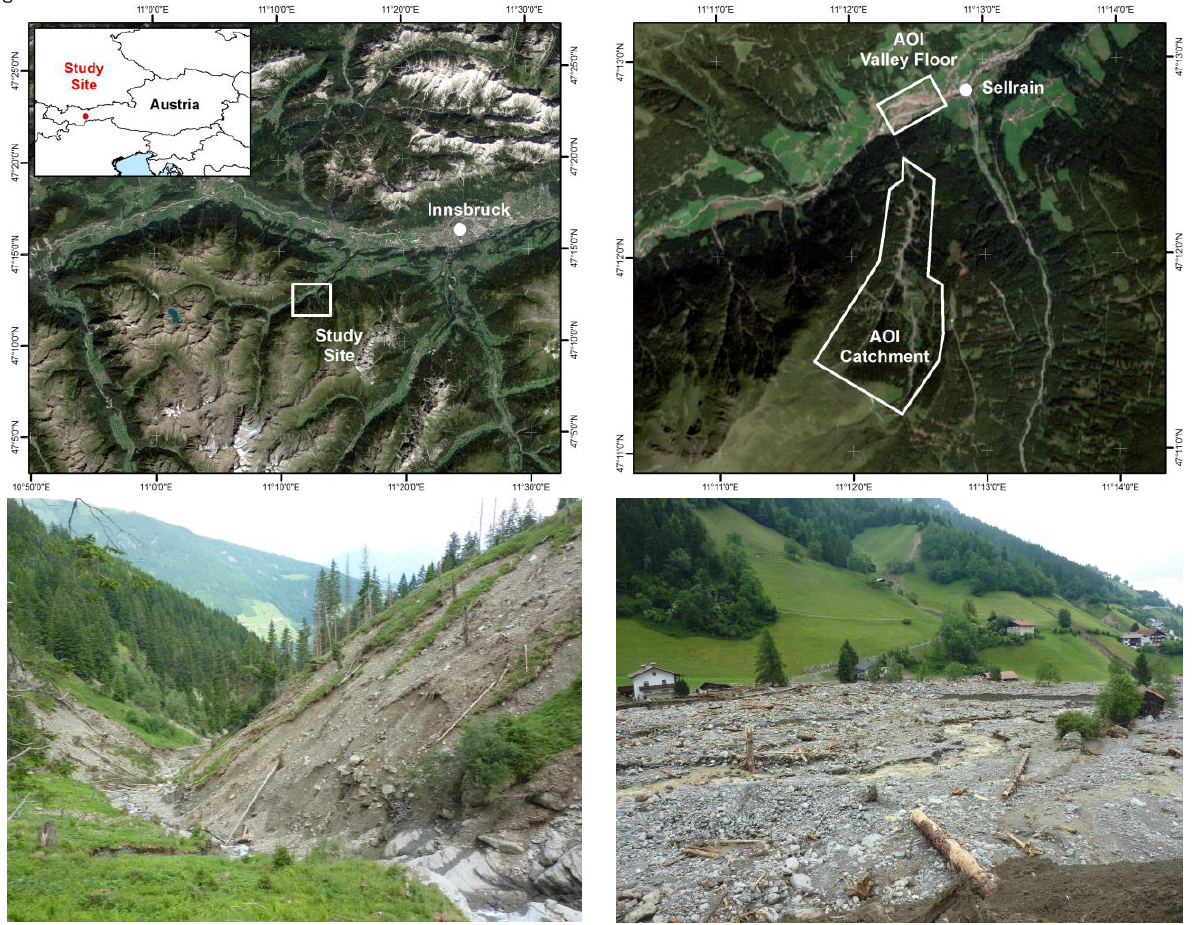
Figure 1. Location of study site in Austria (top left); overview of AOI of the UAS-flights (top right); terrestrial photographs of the catchment on 18 June 2015 (bottom left) and the valley floor on 9 June 2015 (bottom right) (sources: administrative boundaries – GADM, 2016; imagery top row - ESA Sentinel 2A, 2016; photographs bottom row - Pittracher WLV,